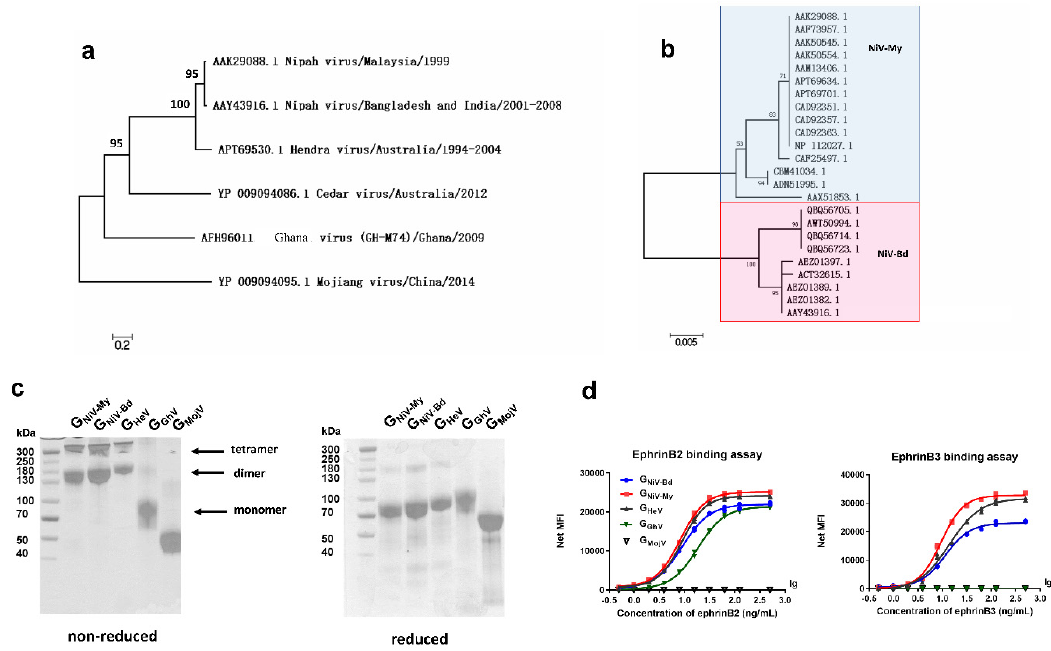
Figure 1. Phylogenetic analysis and expression of soluble G proteins. Molecular phylogenetic analysis of ( a ) henipaviruses-G glycoproteins (HNV-G) and ( b ) Nipah virus-glyco proteins (NiV-G). ( c ) G NiV-My (G protein of Malaysia Nipah virus), G NiV-Bd (G protein of Bangladesh Nipah virus), G HeV (G protein of Hendra virus), G GhV (G protein of Ghana virus), and G MojV (G protein of Mojiang virus) were expressed in the Expi293 suspension cells and purified by affinity chromatography. Purified proteins were assessed on non-reduced and reduced SDS-PAGE gel. ( d ) G proteins are coupled to luminex magnetic microspheres, and the binding between G NiV-My , G NiV-Bd , G HeV , G GhV , and G MojV and ephrinB2 or B3 receptors was then detected using the luminex xMAP multi-factor detection assay. The median fluorescence intensities (MFI) binding curves of the G proteins to receptors are shown. Each concentration contains two replicates, and each replicate is shown.